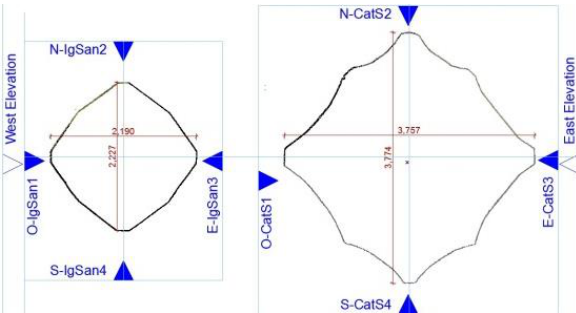
Figure 9. +0.55 m sections of the pillars: the Church of Santiago (left) and the Cathedral of Seville